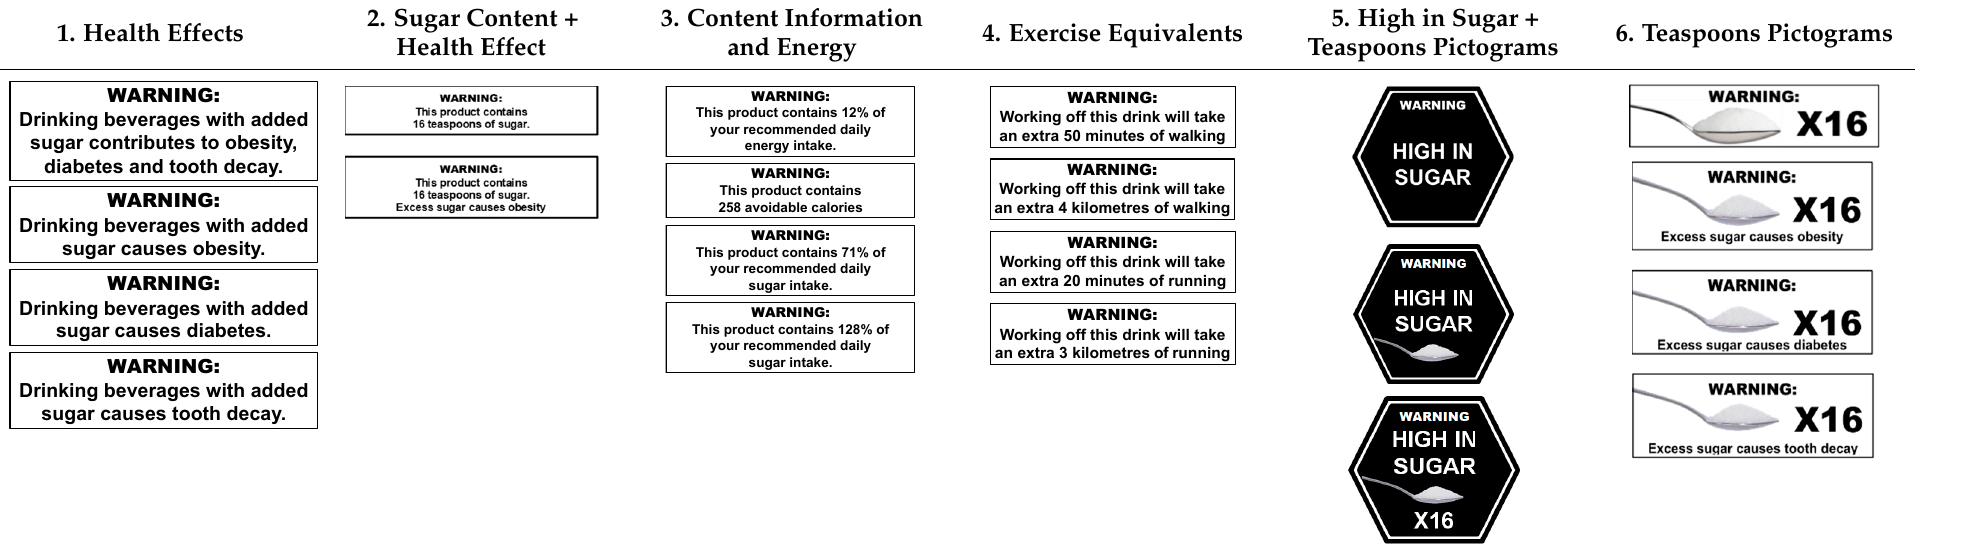
Table 1. Warning label sets, in sequential order (from 1 to 6) as they were shown to participants.